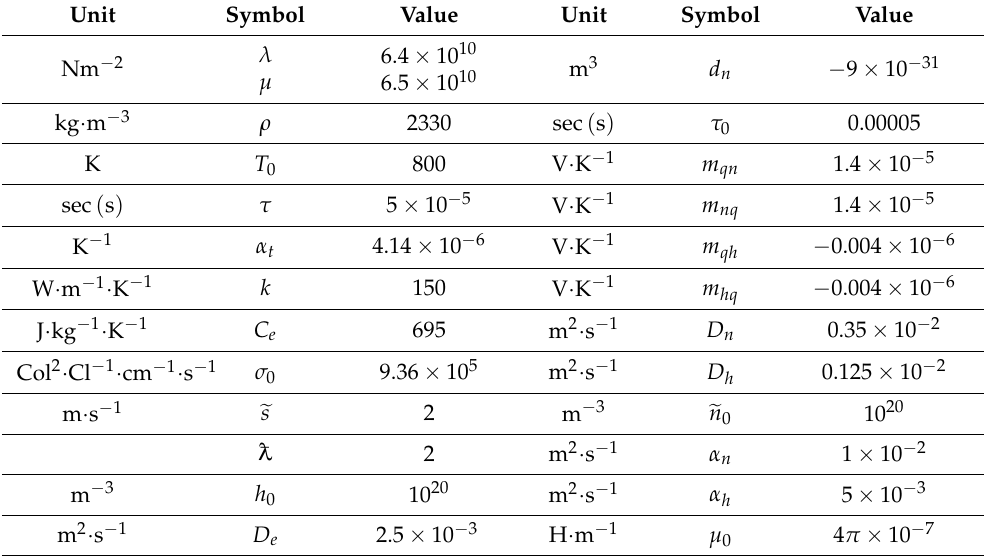
Table 1. The physical input parameters of Si medium in SI